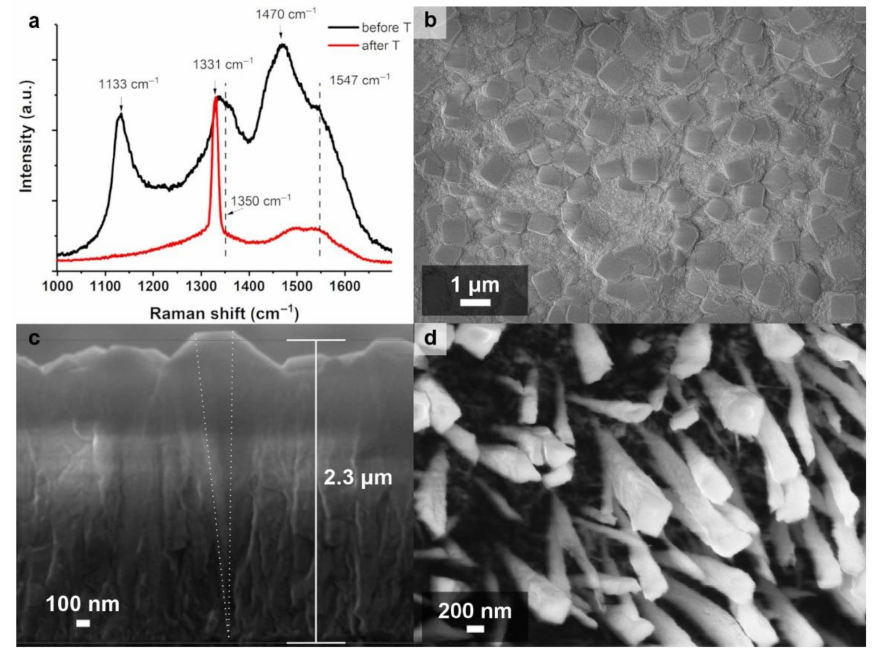
Figure 3. Typical ( a ) Raman spectra and ( b – d ) SEM images of the obtained diamond films. Black spectrum in panel ( a ) (indicated also as “before T”) and the images in panels ( b , c ) are as-grown CVD films. Red spectrum in panel ( a ) (indicated also as “after T”) and the image in panel ( d ) are for the same CVD film after thermal oxidation during 22 h in air at 580 ◦ C. The median thickness of the as-grown diamond film and the location and spatial orientation of the needle (dotted lines) are approximately indicated in cross-sectional SEM image ( c